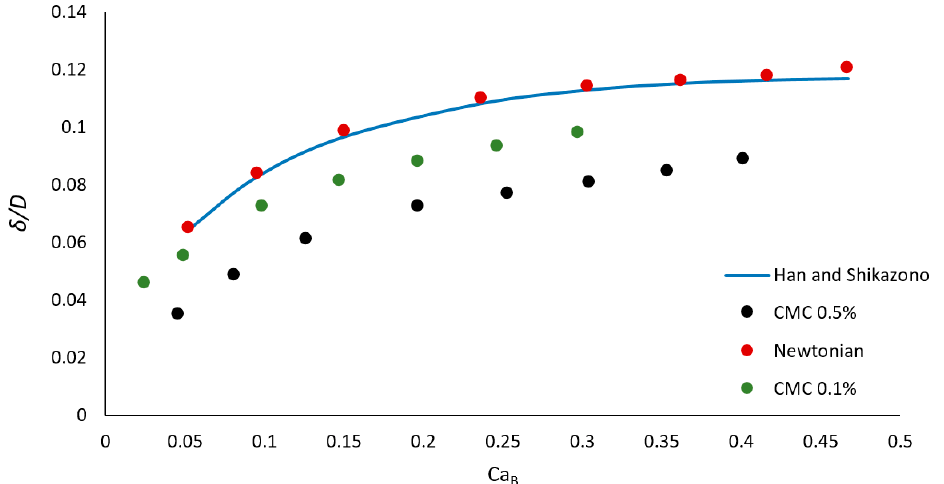
Figure 7. Normalized film thickness as a function of the bubble capillary number. Numerical results are for bubbles flowing in CMC solutions (0.1% and 0.5%) and Newtonian liquid with a viscosity corresponding to the characteristic shear rate. The theoretical predictions are based on the Han and Shikazono [36] correlation. The numerical data concerns the systems with a channel of D = 100 μ m.